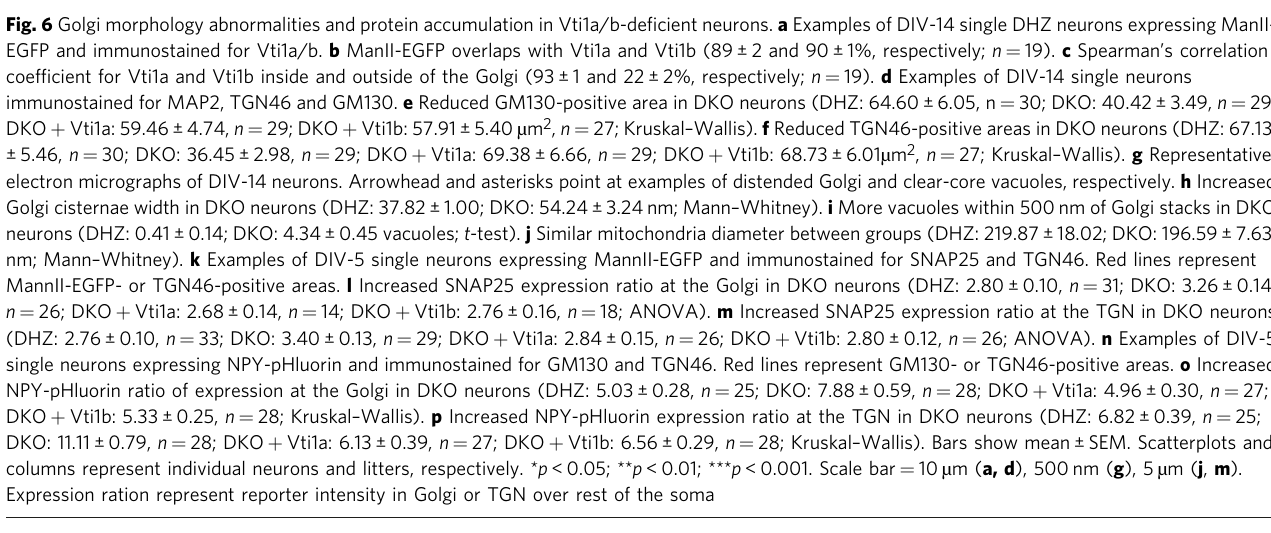
Fig. 6 Golgi morphology abnormalities and protein accumulation in Vti1a/b-de fi cient neurons. a Examples of DIV-14 single DHZ neurons expressing ManII- EGFP and immunostained for Vti1a/b. b ManII-EGFP overlaps with Vti1a and Vti1b (89 ± 2 and 90 ± 1%, respectively; n = 19). c Spearman ’ s correlation coef fi cient for Vti1a and Vti1b inside and outside of the Golgi (93 ± 1 and 22 ± 2%, respectively; n = 19). d Examples of DIV-14 single neurons immunostained for MAP2, TGN46 and GM130. e Reduced GM130-positive area in DKO neurons (DHZ: 64.60 ± 6.05, n = 30; DKO: 40.42± 3.49, n = 29; DKO + Vti1a: 59.46 ± 4.74, n = 29; DKO + Vti1b: 57.91 ± 5.40 µ m 2 , n = 27; Kruskal – Wallis). f Reduced TGN46-positive areas in DKO neurons (DHZ: 67.13 ± 5.46, n = 30; DKO: 36.45 ± 2.98, n = 29; DKO + Vti1a: 69.38 ± 6.66, n = 29; DKO + Vti1b: 68.73 ± 6.01 µ m 2 , n = 27; Kruskal – Wallis). g Representative electron micrographs of DIV-14 neurons. Arrowhead and asterisks point at examples of distended Golgi and clear-core vacuoles, respectively. h Increased Golgi cisternae width in DKO neurons (DHZ: 37.82 ± 1.00; DKO: 54.24 ± 3.24 nm; Mann – Whitney). i More vacuoles within 500 nm of Golgi stacks in DKO neurons (DHZ: 0.41 ± 0.14; DKO: 4.34 ± 0.45 vacuoles; t -test). j Similar mitochondria diameter between groups (DHZ: 219.87 ± 18.02; DKO: 196.59 ± 7.63 nm; Mann – Whitney). k Examples of DIV-5 single neurons expressing MannII-EGFP and immunostained for SNAP25 and TGN46. Red lines represent MannII-EGFP- or TGN46-positive areas. l Increased SNAP25 expression ratio at the Golgi in DKO neurons (DHZ: 2.80 ± 0.10, n = 31; DKO: 3.26 ± 0.14, n = 26; DKO + Vti1a: 2.68 ± 0.14, n = 14; DKO + Vti1b: 2.76 ± 0.16, n = 18; ANOVA). m Increased SNAP25 expression ratio at the TGN in DKO neurons (DHZ: 2.76 ± 0.10, n = 33; DKO: 3.40 ± 0.13, n = 29; DKO + Vti1a: 2.84 ± 0.15, n = 26; DKO + Vti1b: 2.80 ± 0.12, n = 26; ANOVA). n Examples of DIV-5 single neurons expressing NPY-pHluorin and immunostained for GM130 and TGN46. Red lines represent GM130- or TGN46-positive areas. o